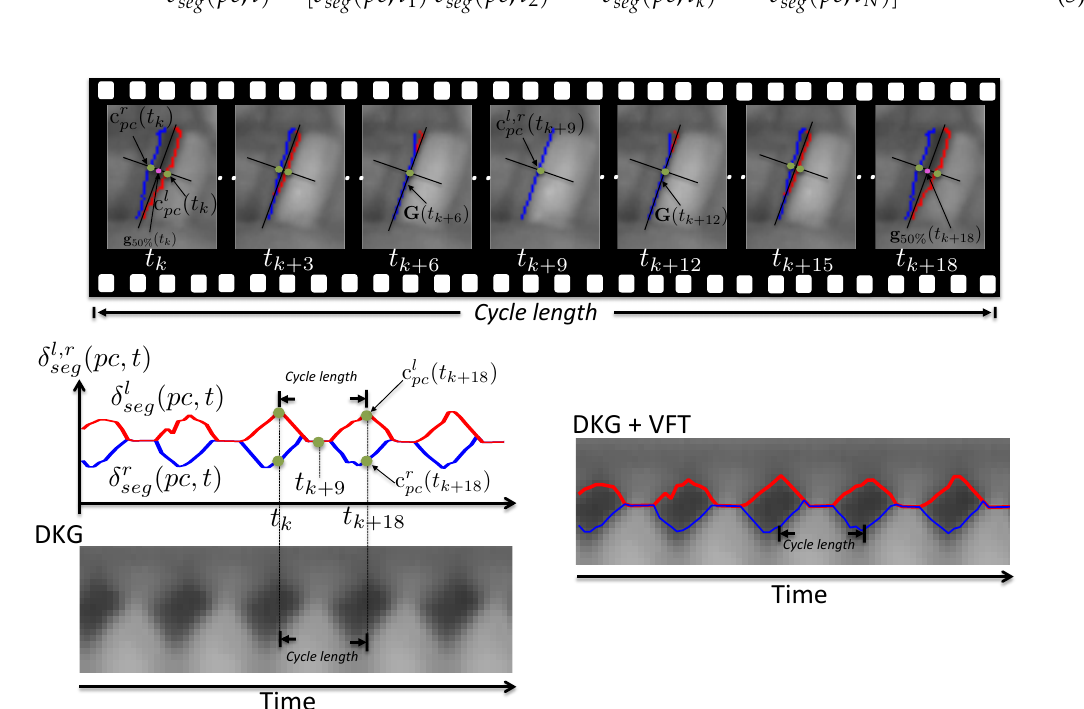
Figure 11. Illustration of the VFT playback. First row: the image sequence of one glottal cycle. Second row: vocal folds trajectories, DKG and DKG+VFT playbacks of five glottal